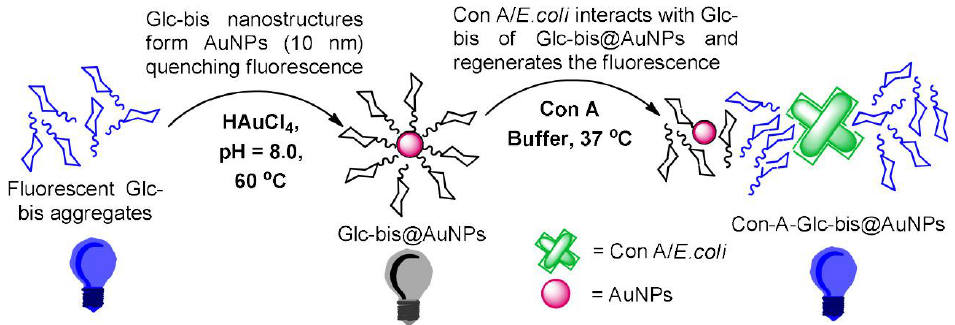
Figure 2. Fluorescence quenching of self − assembled glycopolymers and gold nanoparticles and emission recovery after addition of ConA. Figure reproduced from ref. [22] with permission.